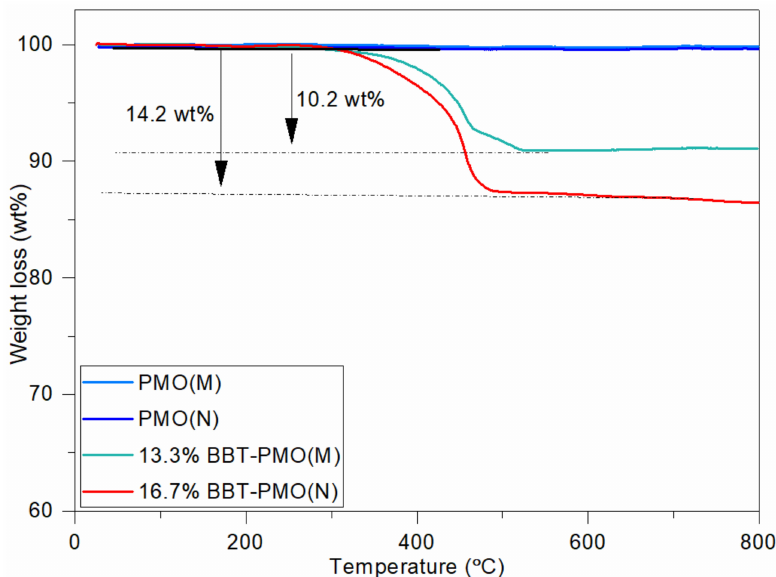
Figure 6. TGA of PMO(M), PMO(N), 13.3% BBT-PMO(M), and 16.7%